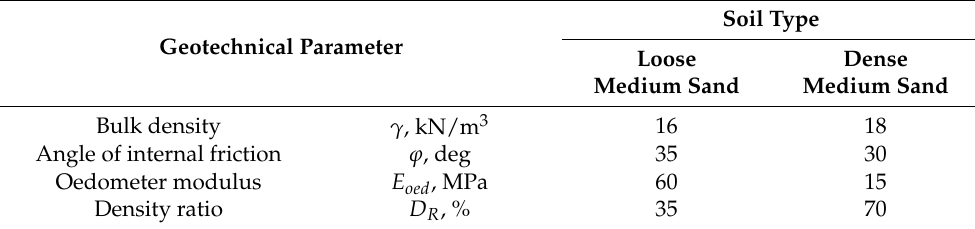
Table 7. Geotechnical parameters of soils which were asummed in